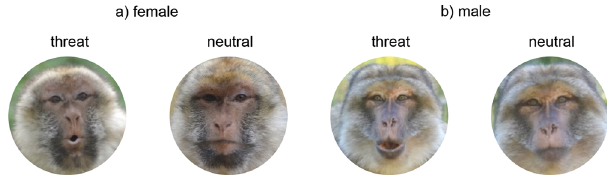
Fig. 5 Examples of stimuli used in the experiment. a Example of a female agonistic and neutral facial expression. b Example of a male agonistic and neutral facial expression. Note that in contrast to other macaque species such as rhesus monkeys, Barbary macaques do not produce ‘ coos ’ . Thus, the pictures shown can be unequivocally categorised as open-mouth threat faces. Photographs were taken by Eva-Maria